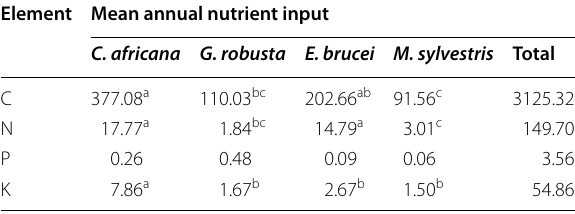
Means followed by different letters on the same rows indicate significant differences at P < 0.05.log transformed data. Source: Survey